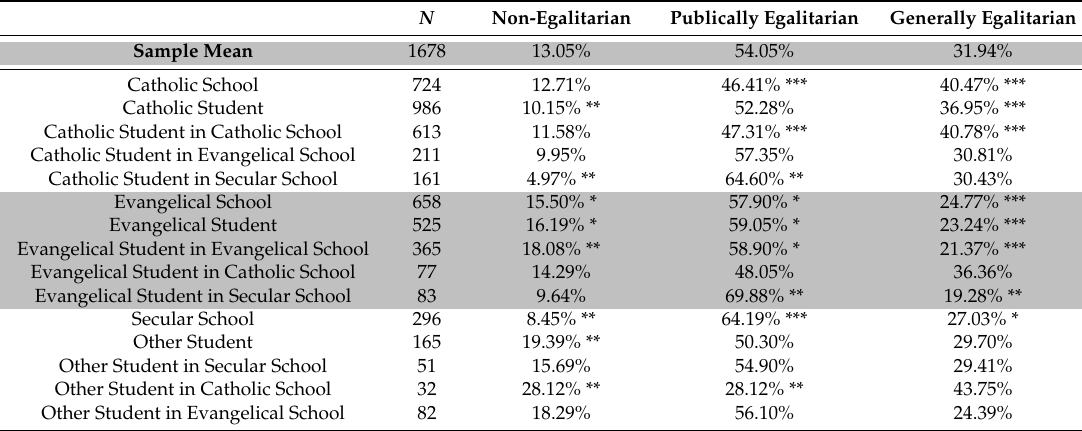
Table 4. Crosstab Comparison of Gender Attitudes between Religious